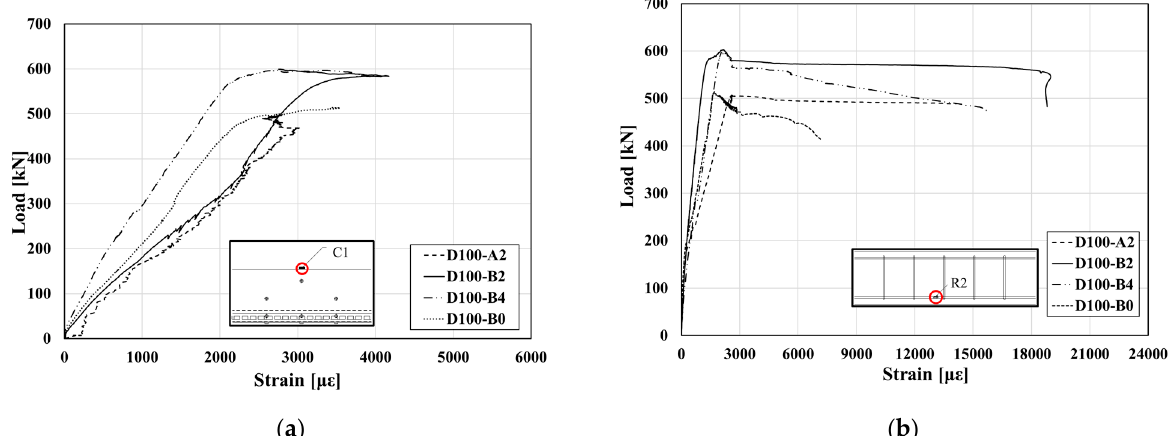
Figure 16. The Load-strain relationships: ( a ) C1 Guage; ( b ) R2 Gauge .